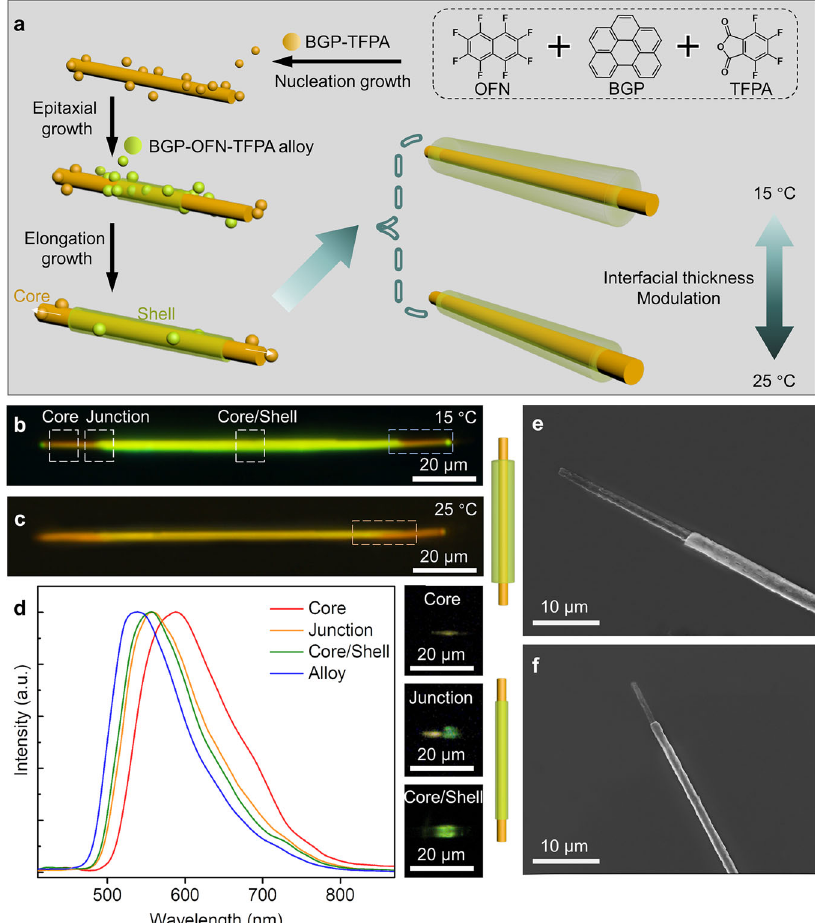
Fig. 4 The synthesis and characterization of core/shell triblock nanowires. a Schematic illustration of the synthesis of orange-orange/olive-orange triblock nanowires. b FM images of triblock nanowires formed at 15 °C. c FM images of triblock nanowires formed at 25 °C. d PL spectra collected from three sections marked in ( b ). Insets are the corresponding FM images excited by laser beam λ = 375 nm. e , f SEM images of two types of triblock nanowires with different thickness.